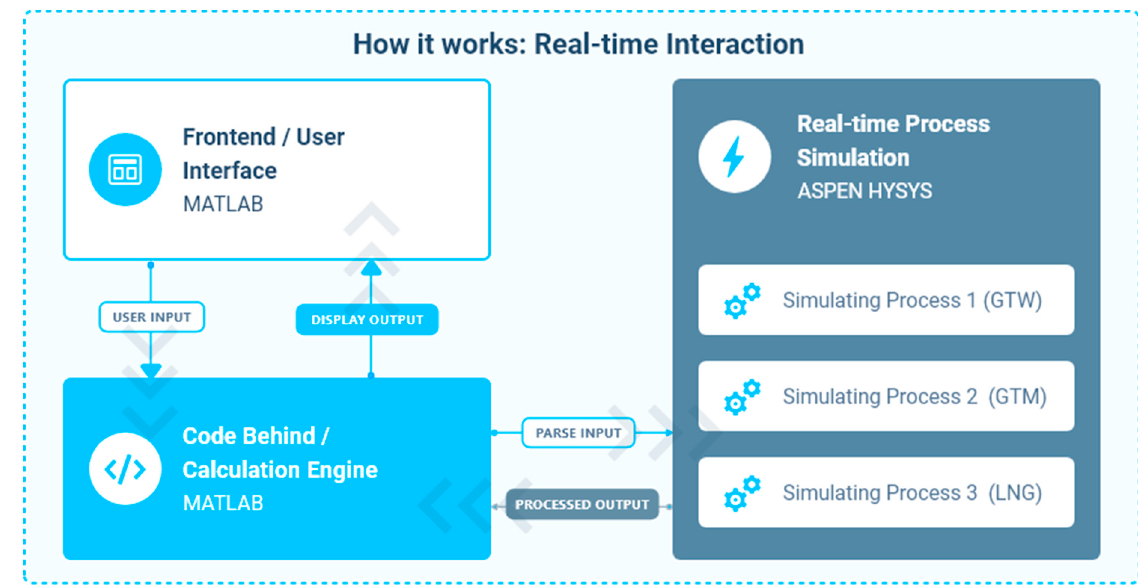
Figure 11. Real-time interaction with the process simulations.